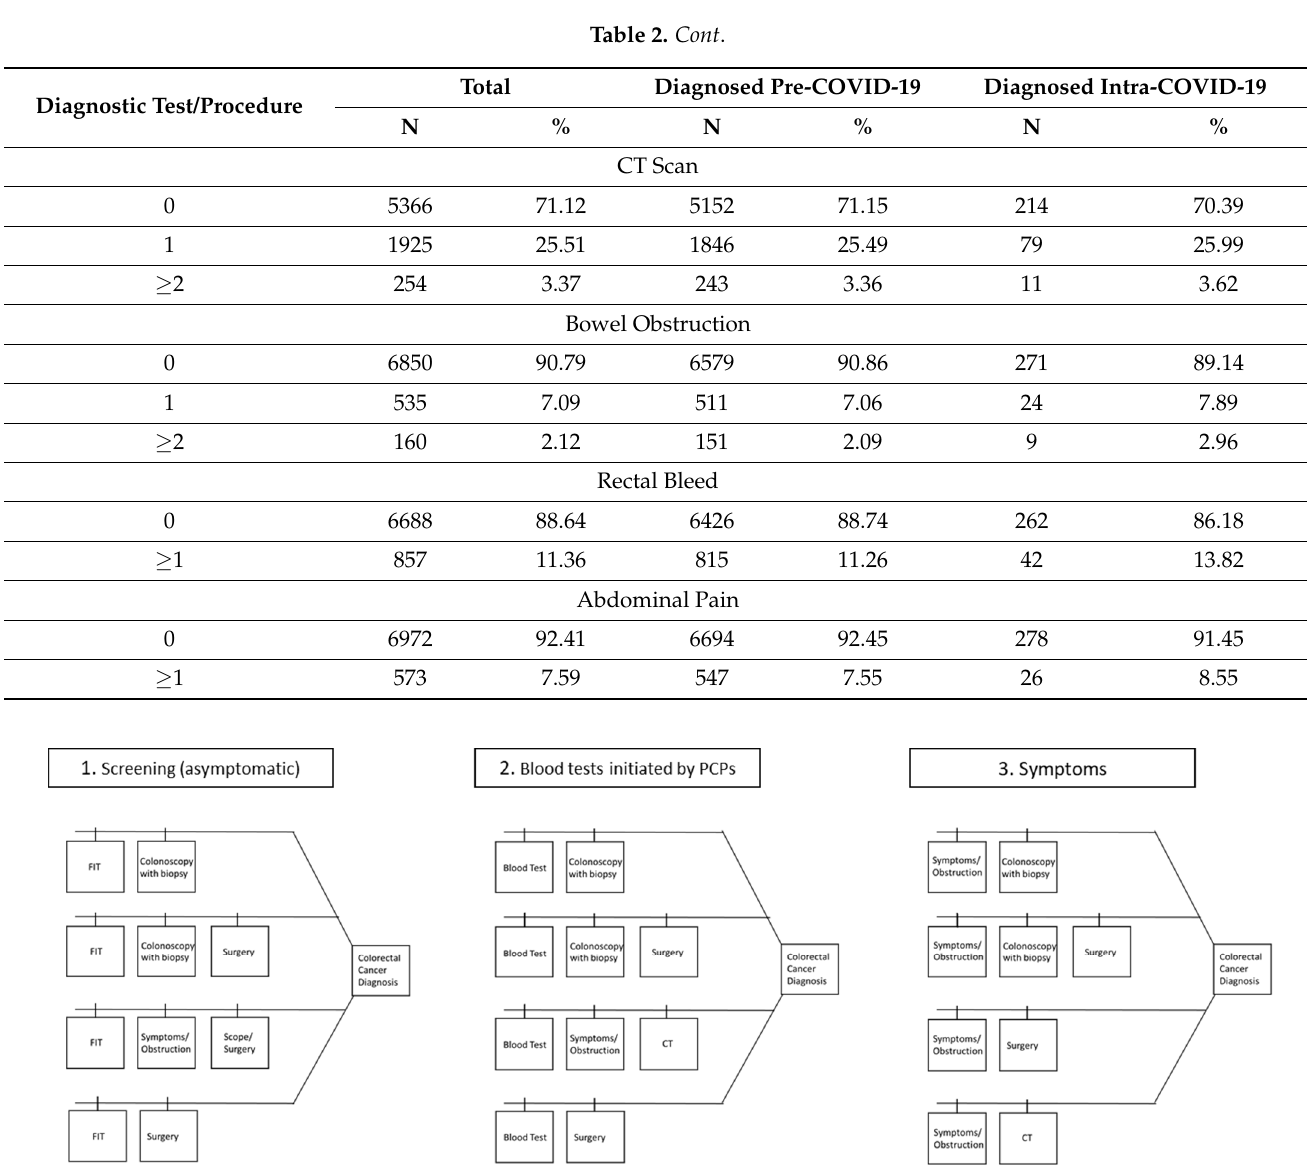
Figure 2. Refined diagnostic pathway frameworks among 7545 patients diagnosed with colorectal cancer between 1 January 2016 and 1 July 2020 in Alberta, Canada. PCP = Primary care physicians.